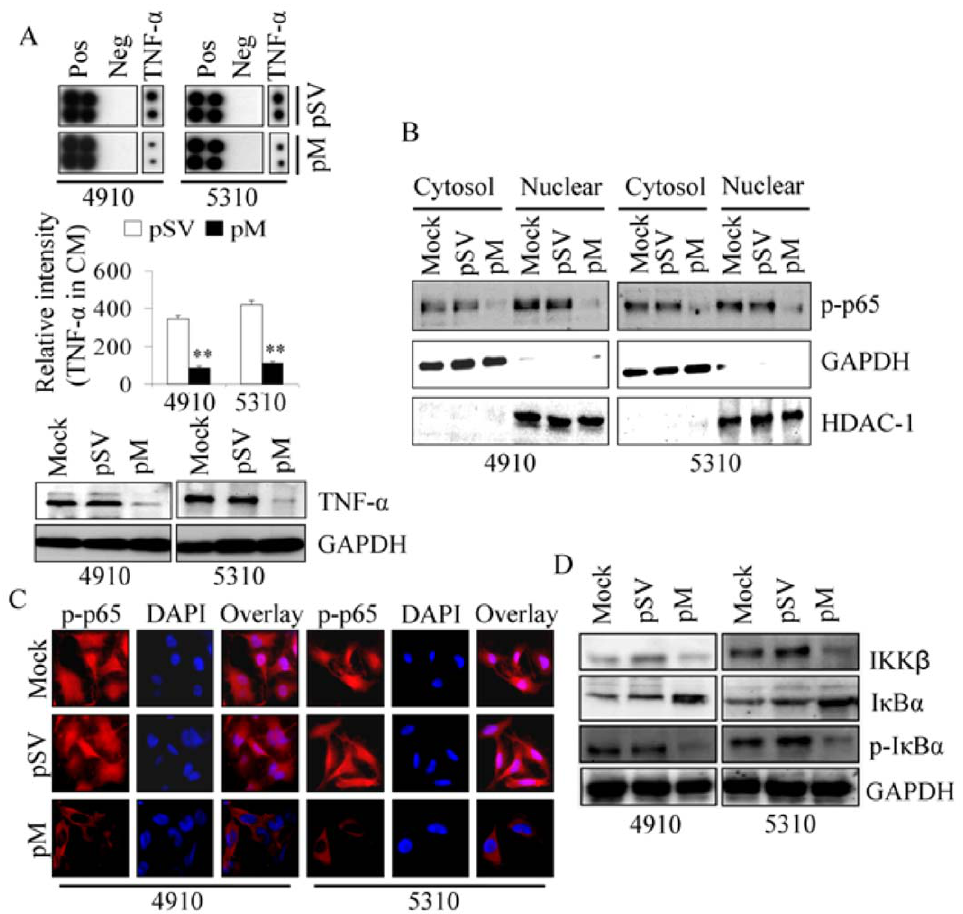
Figure 3. MMP-2siRNA induced inhibition of TNF- a mediated phosphorylation and nuclear translocation of p65 subunit of NF- k B in 4910 and 5310 xenograft cell lines. A. The 4910 and 5310 cells were transfected with either pSV or pM for 72 h as described in Materials and Methods. Conditioned medium (CM) was collected and subjected to cytokine array following manufacturer’s instructions. The positive (Pos) and negative (Neg) controls show biotin-conjugated and non-biotinylated IgG respectively on the array. The tumor necrosis factor-alpha (TNF- a ) levels in pSV (Scrambled Vector) control and pM (MMP-2siRNA) treatments were compared and relative intensity was estimated by densitometric analysis using ImageJ 1.42 (NIH). The arithmetic mean 6 SE values obtained from two independent repetitions were plotted in the bar diagram and significance was represented by ‘‘**’’, at p , 0.01. Whole cell lysates subjected to Western blotting to check the TNF- a expression levels. B. Cytoplasmic and nuclear extracts were subjected to Western blotting where HDAC-1 and GAPDH were used as internal controls for nuclear and cytosolic fractions, respectively. C. Immunocytochemistry showing the expression levels of phospho-p65 in mock, pSV and pM treated 4910 and 5310 cells. Cells were fixed in paraformaldehyde and incubated with anti-phospho-p65 antibody followed by Alexa Fluor H anti-rabbit secondary antibody, mounted and the expression levels and cellular localization of phospho-p65 were captured under a confocal microscope. The nucleus was counterstained with DAPI. D. The expression levels of IKK b , I k B a , and pI k B a were determined in the whole cell lysates from mock, pSV- and pM-treated cells at 72 h post- transfection. Blots are representative of three independent experiments where GAPDH served as loading control.